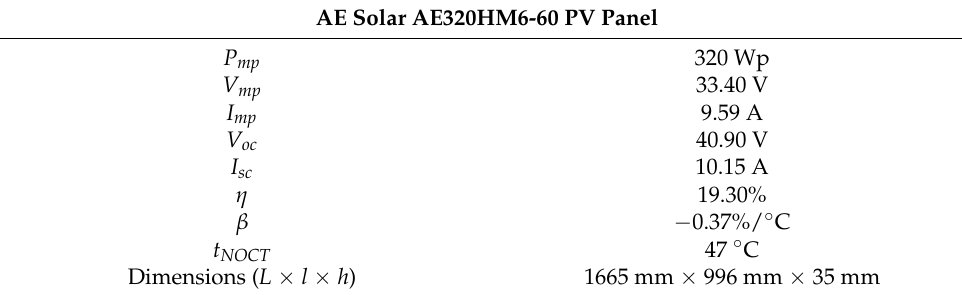
Table 1. General characteristic for the considered PV